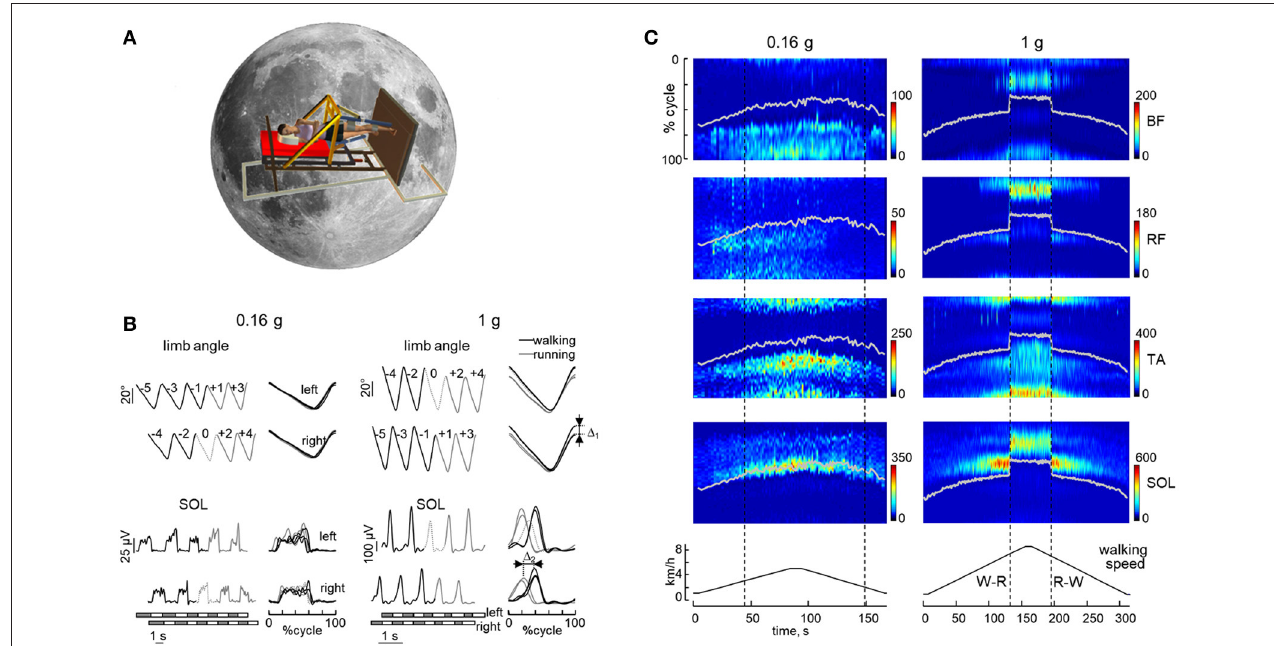
FIGURE 4 | Abruptness of gait transitions on Earth (1g) and smoothness of gait transitions at reduced simulated gravity (0.16g) during slow changes in treadmill belt speed. (A) simulation of Moon (0.16g) gravity was obtained by using the tilted BWS system ( Figure 3C ). (B) limb angle and soleus EMG waveforms (left, plotted vs. time; right, plotted vs. normalized cycle) during five consecutive strides of both legs around the transition from walking (black lines) to running (gray lines). Dotted curves denote the transition stride (stride 0, in which the swing phase first exceeded 50% gait cycle). Bottom horizontal bars denote swing (white) and stance (black) phases. 1 1 and 1 2—abrupt changes in the limb angle and the timing of the SOL activity peak at gait transition at 1g (between stride + 1 and stride − 1). (C) example of EMG patterns during slow changes in treadmill speed. The color maps represent a sequence of discrete activation waveforms (vertical slices): x-axis indicates the number of the gait cycles (corresponding to the appropriate timing of the trial), y-axis indicates normalized gait cycle, and color indicates EMG amplitude. The white line indicates when toe off occurred. Vertical dashed lines indicate walk-to-run (W-R) and run-to-walk (R-W) transitions. RF, rectus femoris; BF, biceps femoris; TA, tibialis anterior; SOL, soleus. Adapted from Sylos-Labini et al.